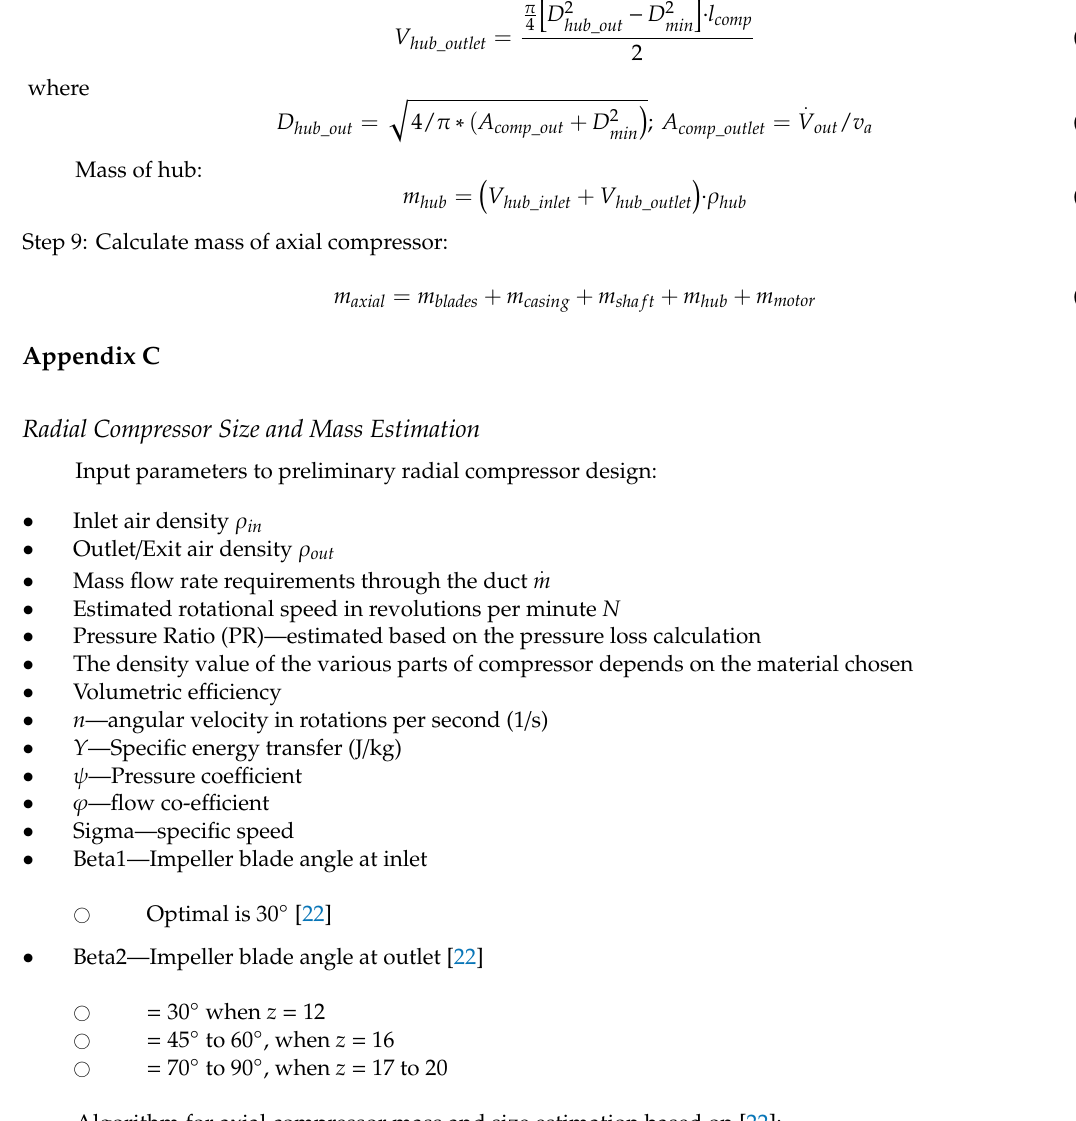
Algorithm for axial compressor mass and size estimation based on